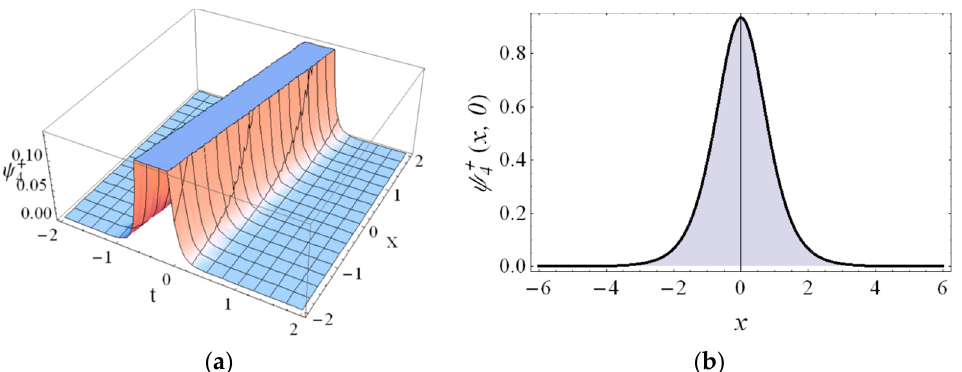
( x , t ) with k = 1, c = 6. ( a ) 3-D plot, ( b ) 2-D curve for 4